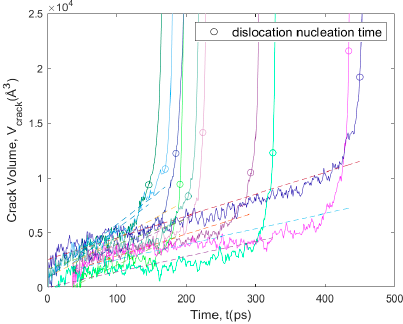
Figure 6. Crack volume as a function of time for simulations with T = 400 K and σ H = 6.0 GPa, each with a different random seed for atomic velocity initialization. Dashed lines denote the lattice-trapped delamination rates and circles mark the appearance of a dislocation.